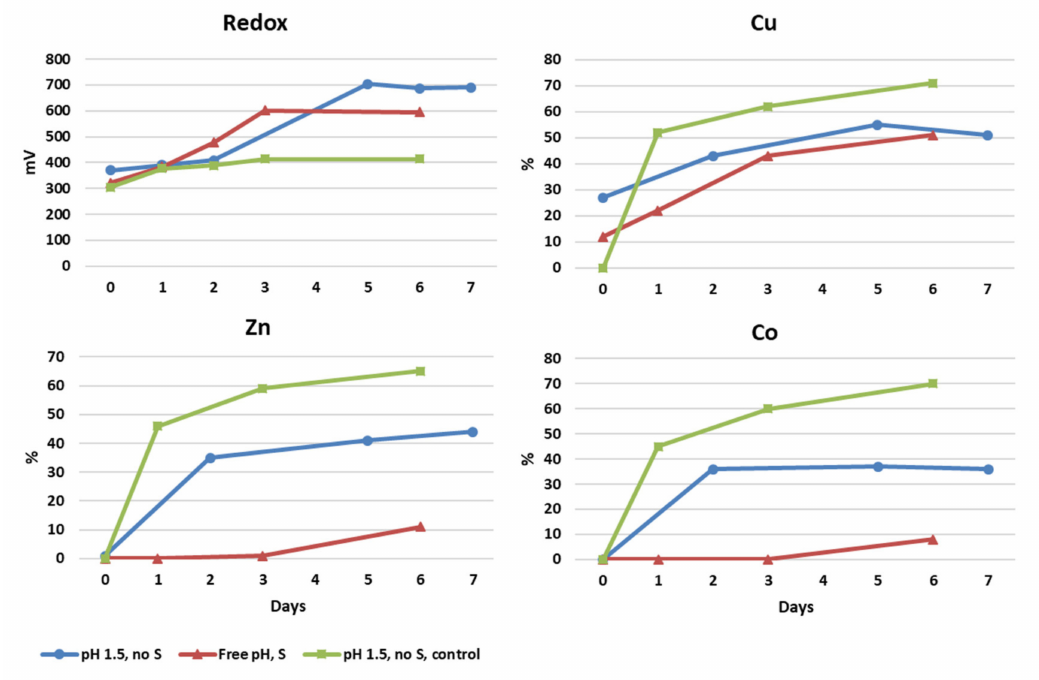
Figure 4. Redox potential and metal yields of Cu, Zn, and Co in the 1 L reactor experiments at a 10% pulp